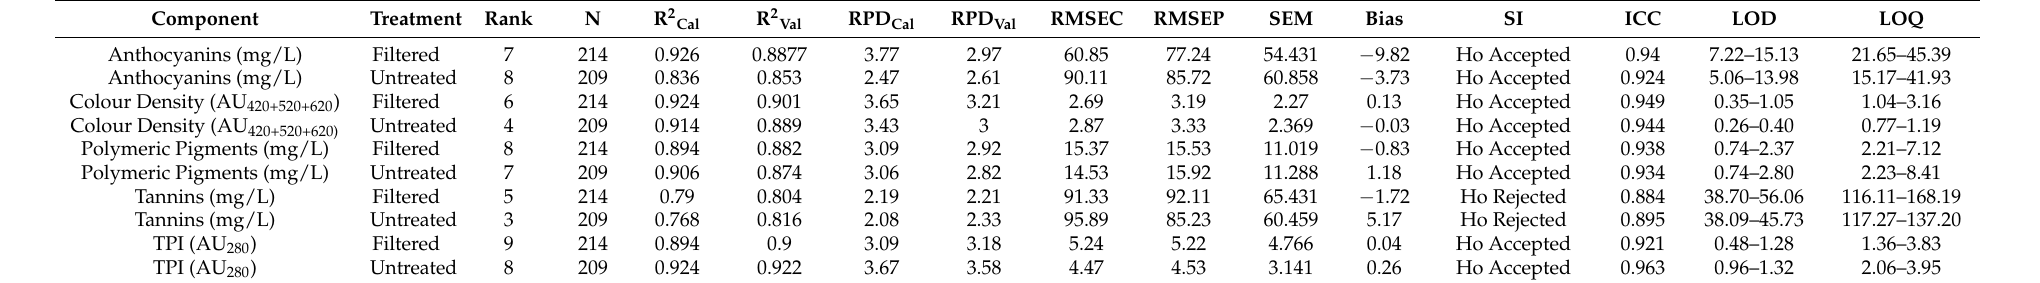
Table 2. Summary statistics for filtered and untreated samples using attenuated-reflection Fourier-transform mid-infrared (ATR-FT-MIR) spectroscopy. Component Anthocyanins